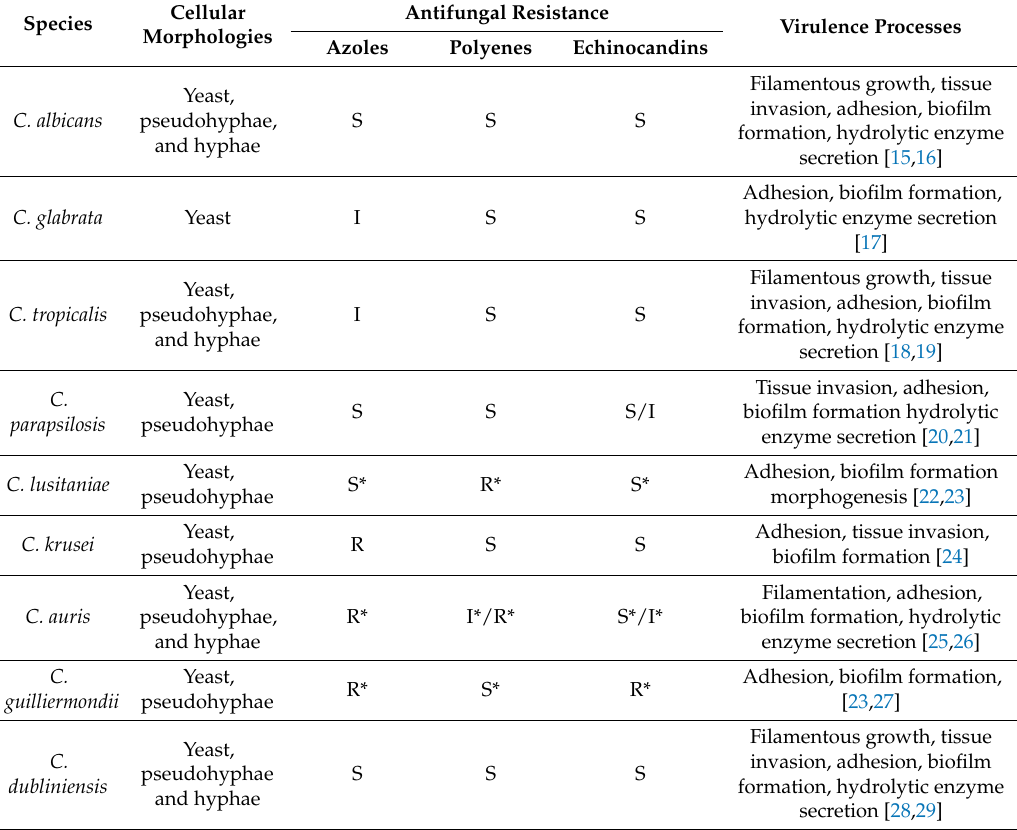
Table 1. Candida species: morphogenesis, antifungal responses and virulence